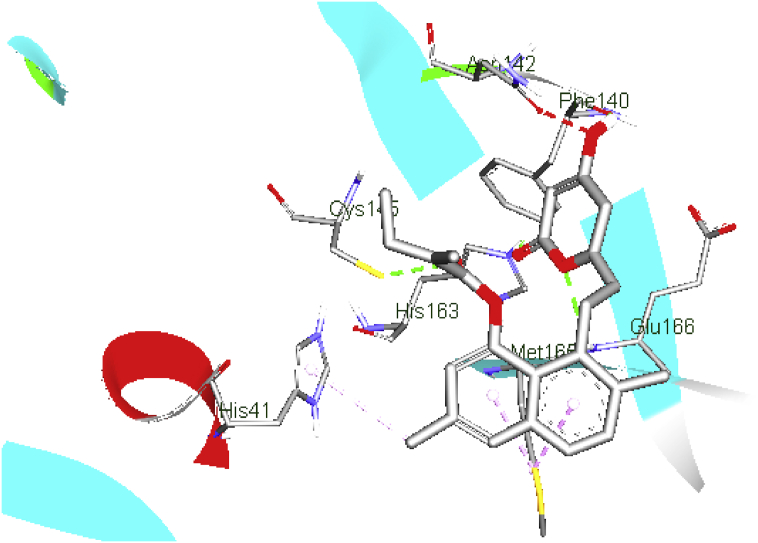
Schematic representation of COVID-19 main protease (PDB: 6LU7) interactions with lovastatinImage 1 protein Image 2 ligand Image 8 hydrophobic interaction Image 9 hydrogen bond.